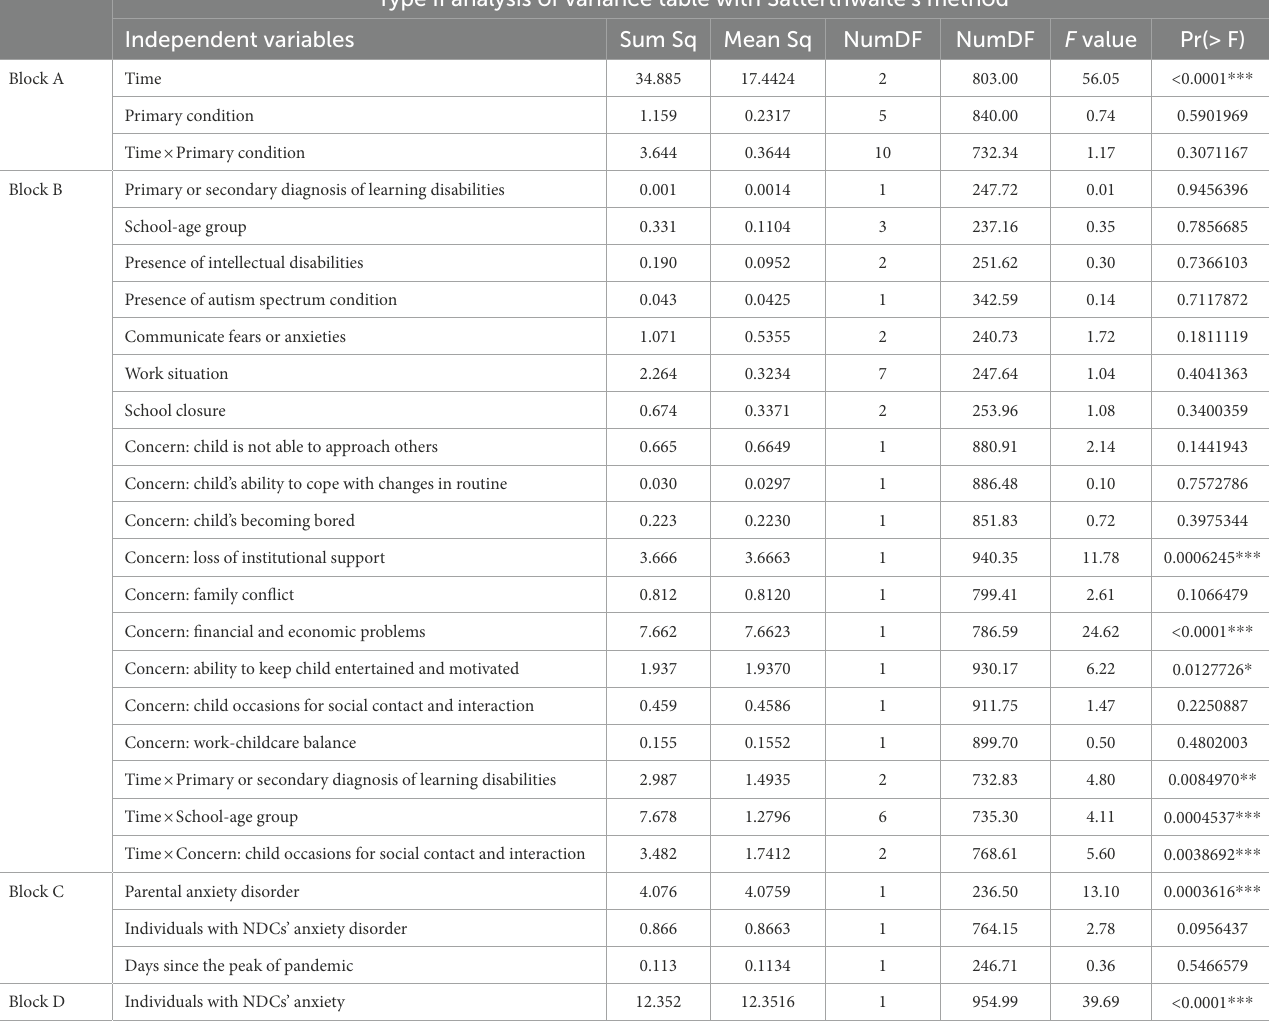
TABLE 1 Conditional multilevel analysis on parental anxiety. Type II analysis of variance table with Satterthwaite’s